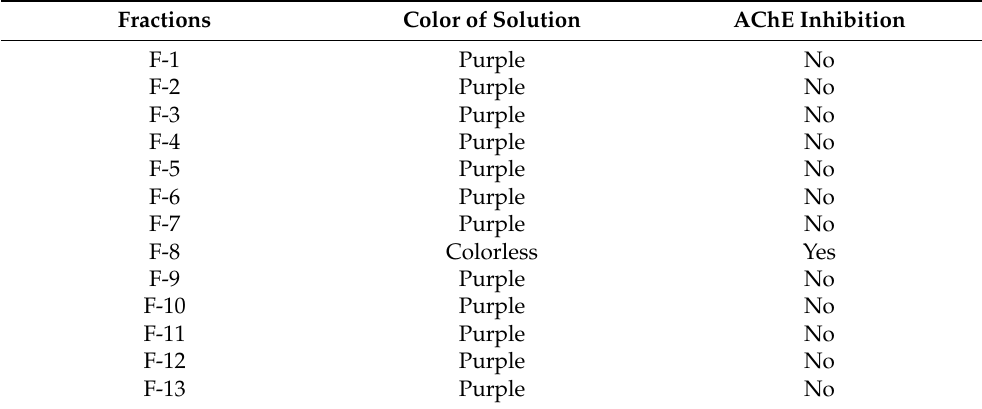
Table 1. In vitro analysis of the purified fraction of P. anisum for anti ‐ cholinesterase activity.